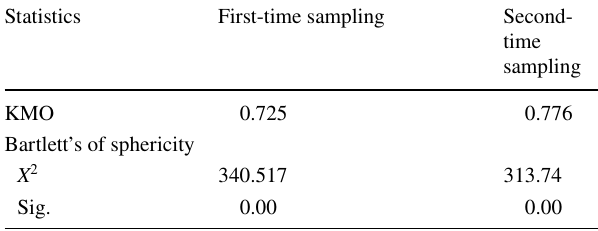
Table 3 Results of KMO and Bartlett test for studied parameters in the lake and downstream of the Gotvand-e-Olya Dam